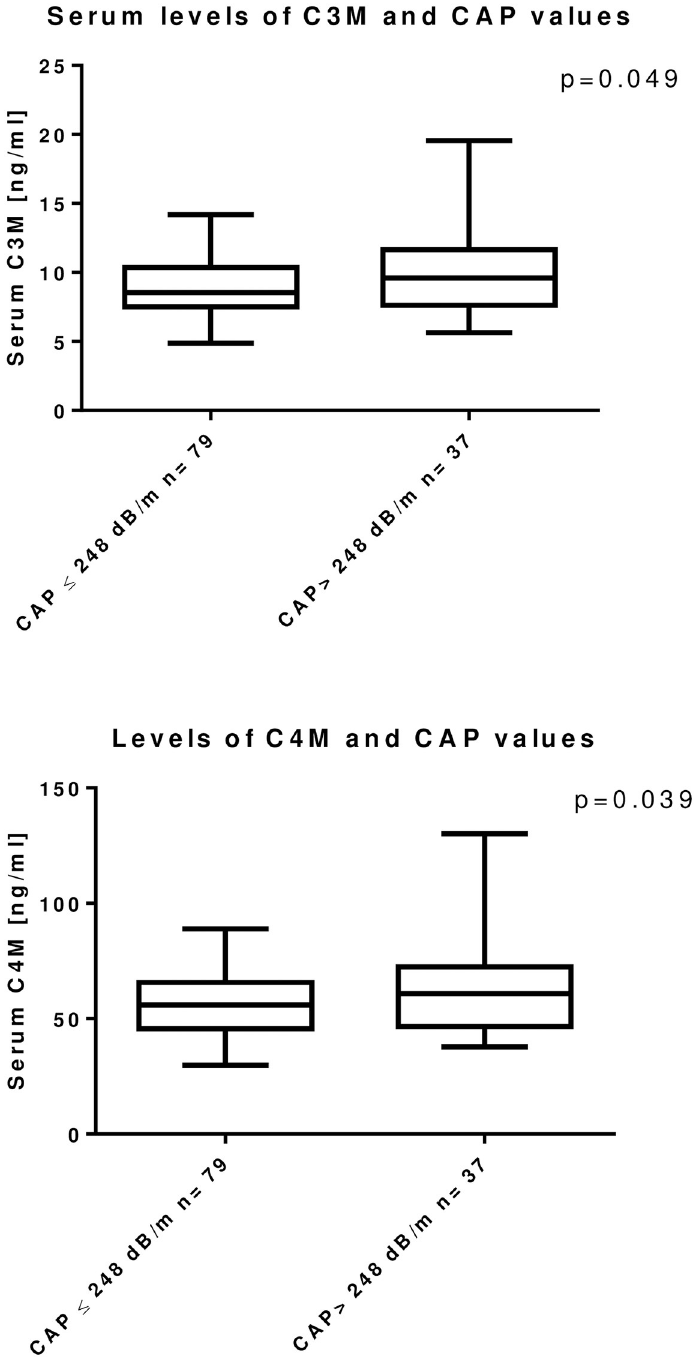
Fig 3. Levels of C3M and C4M in the blood of HIV positive patients correlates with steatosis measured by CAP. In patients with an increased liver fat content, higher C3M levels (p = 0.046) and higher C4M levels (p = 0.039) were detected in blood